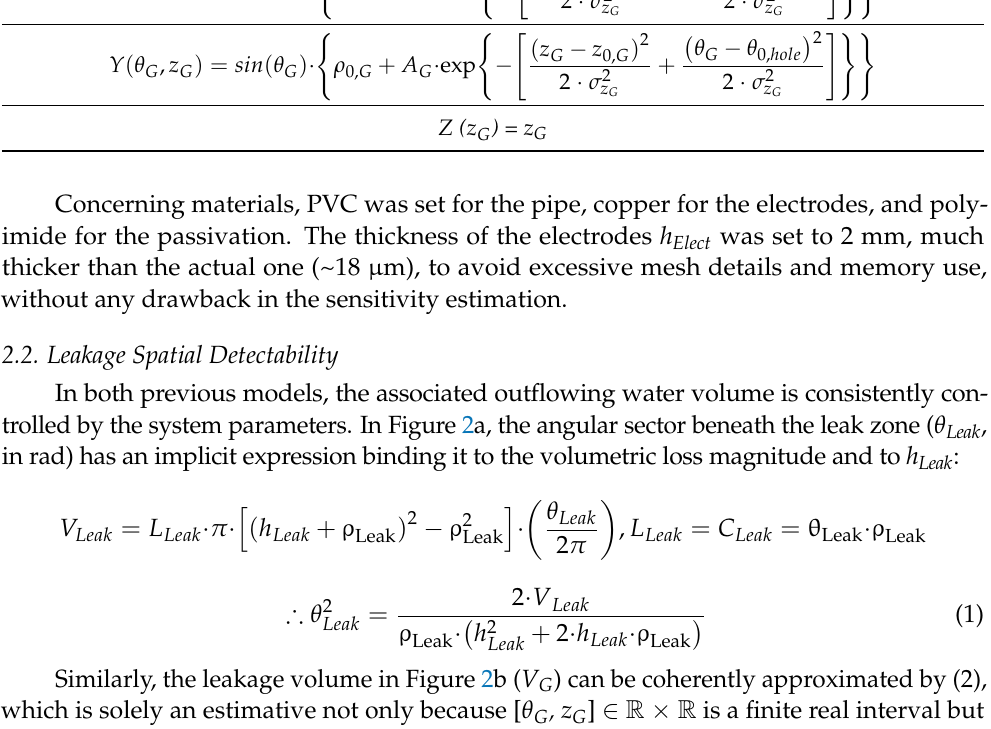
Figure 3. ( a ) Detail on conduit hole used to inject the leak in the real scenario, θ H being the angular coordinate and h H its own height variable (spanning up to the pipe thickness), both imposed to model its corresponding surfaces. Moreover, θ 0,hole refers to the center of the inner aperture. ( b ) Passivation with 50 μ m Kapton ® tape (2) and ionic double layer (3) on top of a 2 mm Cu electrode (1). Table 1. Parameterization example focusing on the Gaussian-alike f(x,y,z) top surface equations. X ( θ G , z G ) = cos ( θ G )